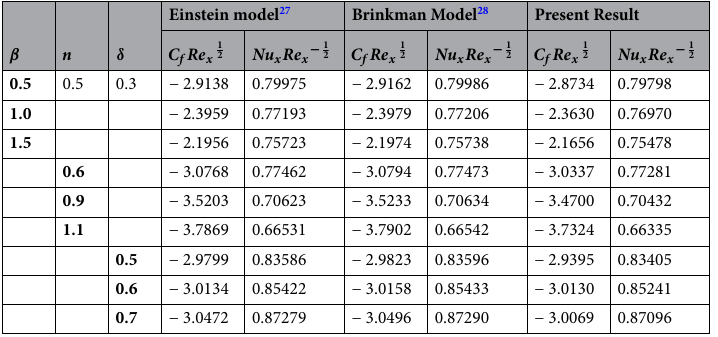
1 1 2 with distinct models of viscosity. Significant 2 and Nu x Re x −